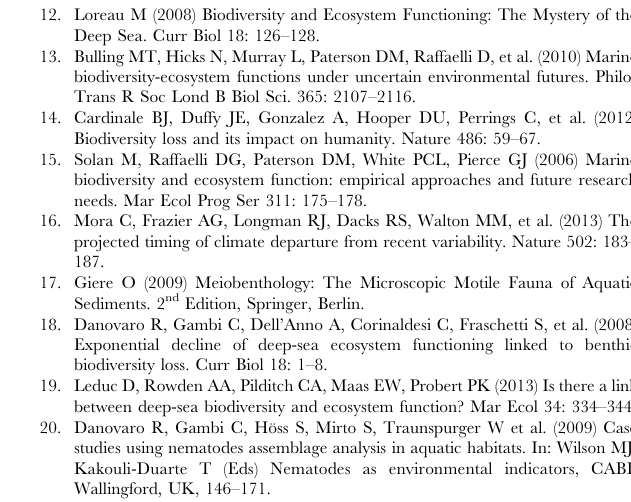
Figure S1 Contribution of all taxa (i.e., nematodes, copepods and polychaetes excluded) to the meiofaunal communities in the seagrass, mangrove and reef habitat of the Caribbean Sea (A), Red Sea (B) and Celebes Sea (C). Table S1 Meiofaunal and nematode beta diversity among habitats within each region and among regions for each habitat